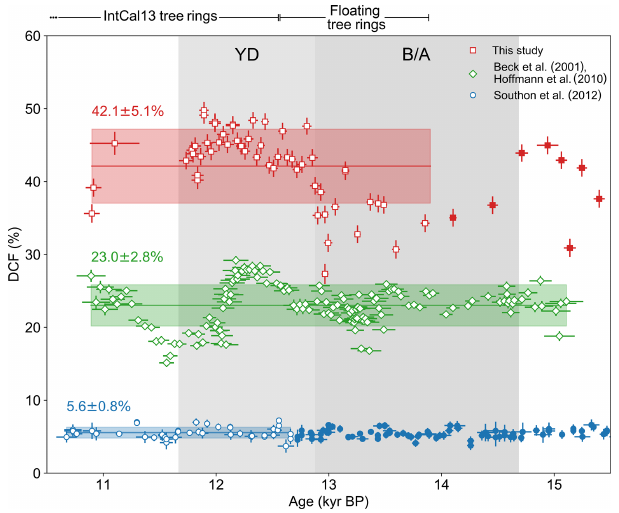
Figure 6. Very high and varying DCF for stalagmite M1-5 (this study) in comparison to records included in calibration data sets (Beck et al., 2001; Hoffmann et al., 2010; Southon et al., 2012). Whereas H82 DCF values are low and constant, the Bahamas DCF values are higher and show nonrandom structures between 11.2 and 12.7kyrBP. Empty symbols indicate the used reference area for the respective calibration study; the shaded colored areas represent mean values and standard deviation of DCF values in the respective reference areas. Areas of available tree-ring records (Reimer et al., 2013) are indicated on top of the